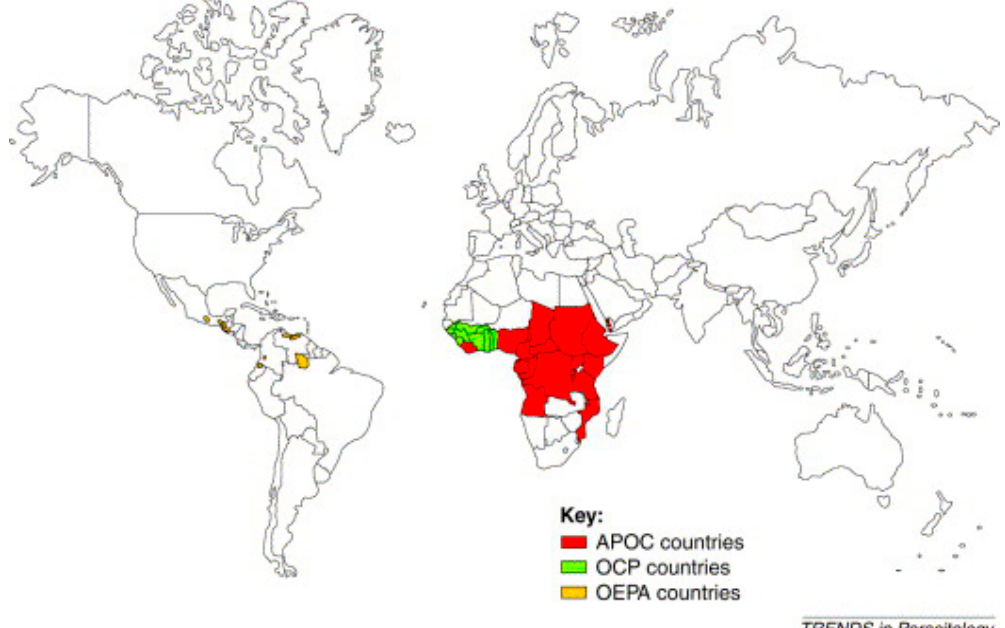
Figure 1. World map of onchocerciasis control programs [21].